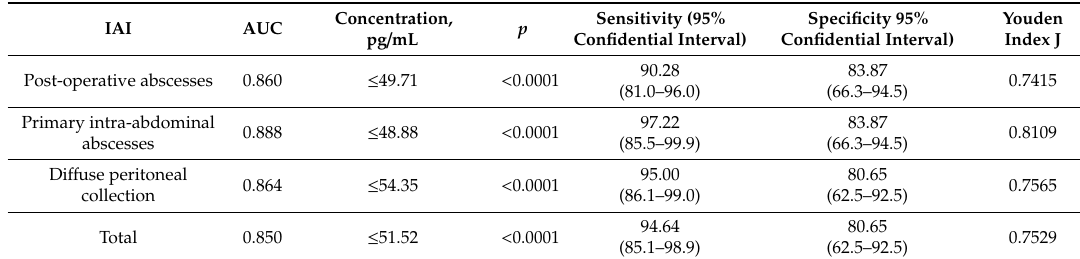
Table 2. ROC analysis result for serum IL-8 in patients with IAI of different origin.